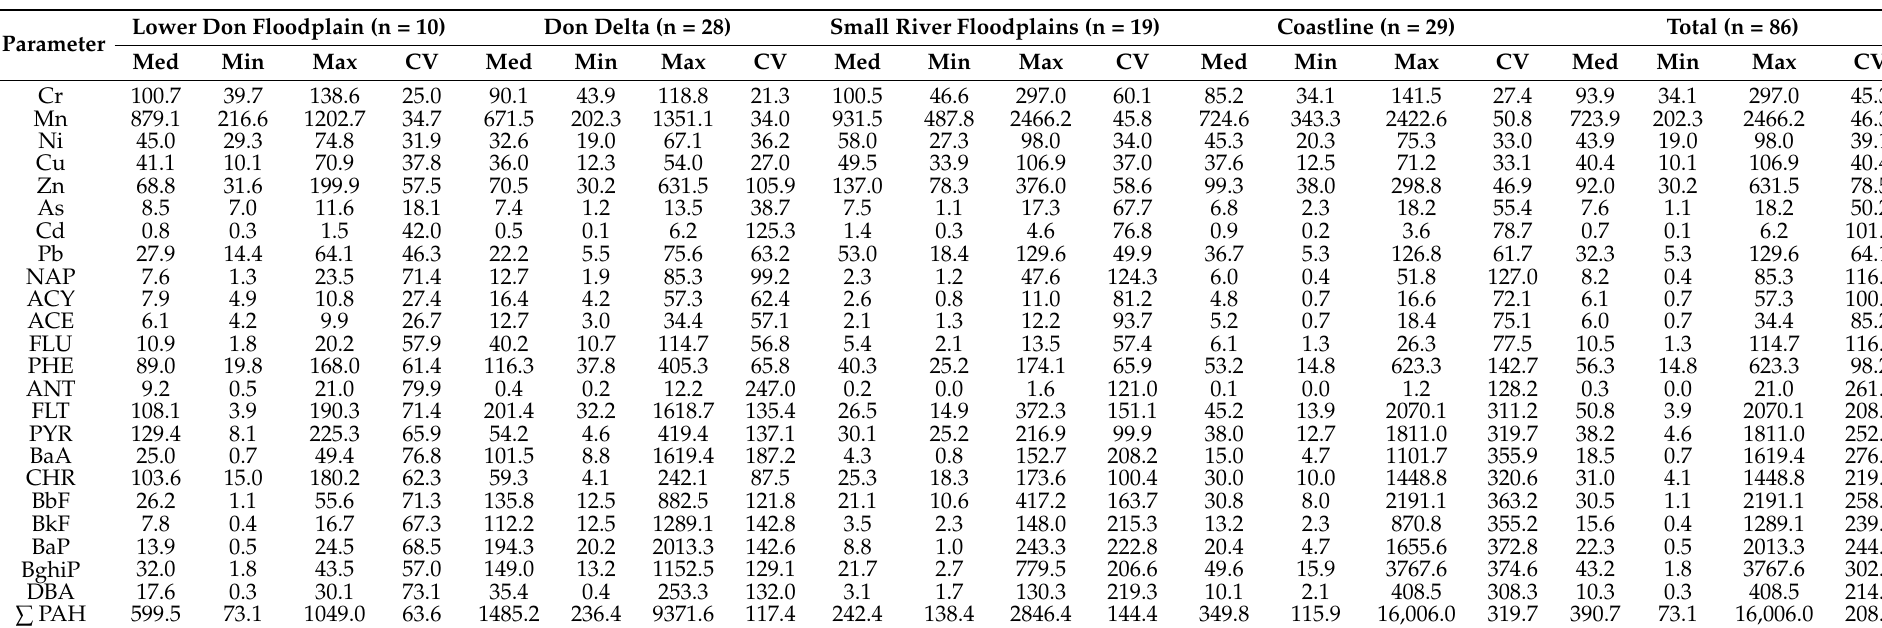
Table 6. Descriptive statistics for the PTE (mg kg − 1 ) and PAH ( µ g kg − 1 ) concentrations in topsoils from the Lower Don floodplain and the Taganrog Bay coast.